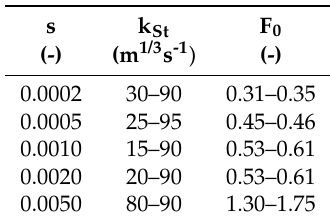
Table 2. Summary of numerical conditions. k St is the roughness coefficient in the Strickler formula for uniform